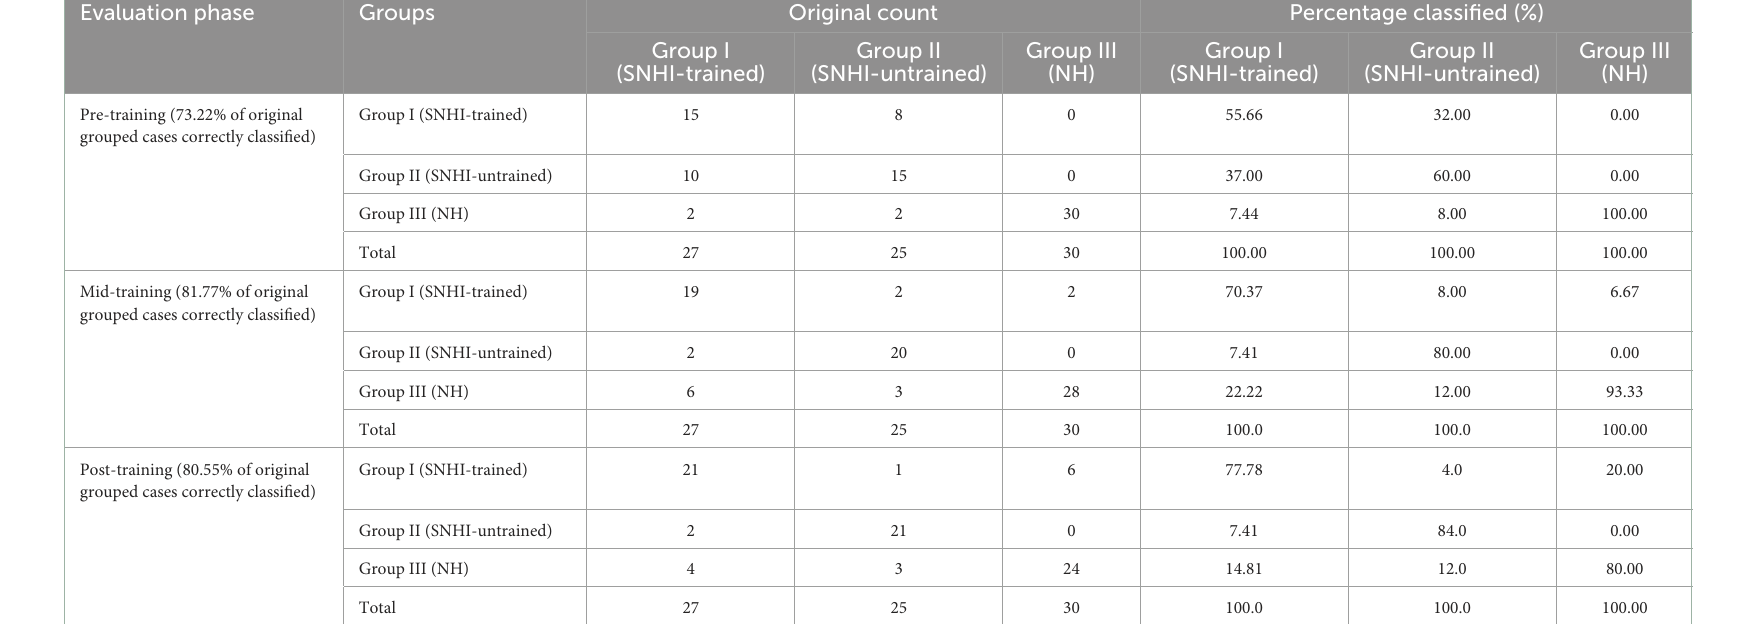
TABLE 5 Classification results for groups in pre-, mid-, and post-training evaluation